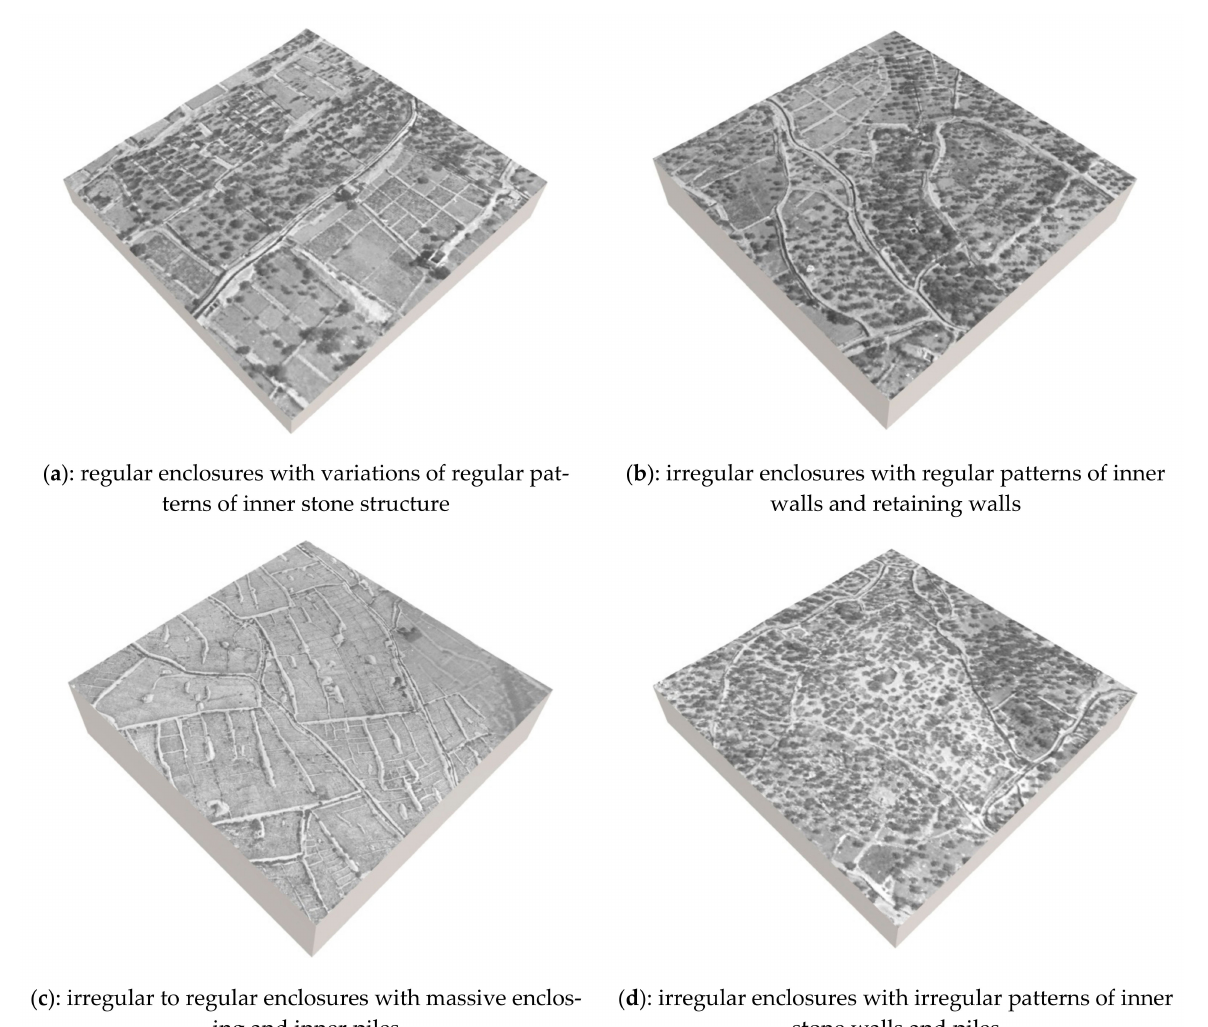
Figure 31. Types of karst enclosures found in the Cres olive grove. Elaboration is based on aerial imagery from 1953 and digital elevation